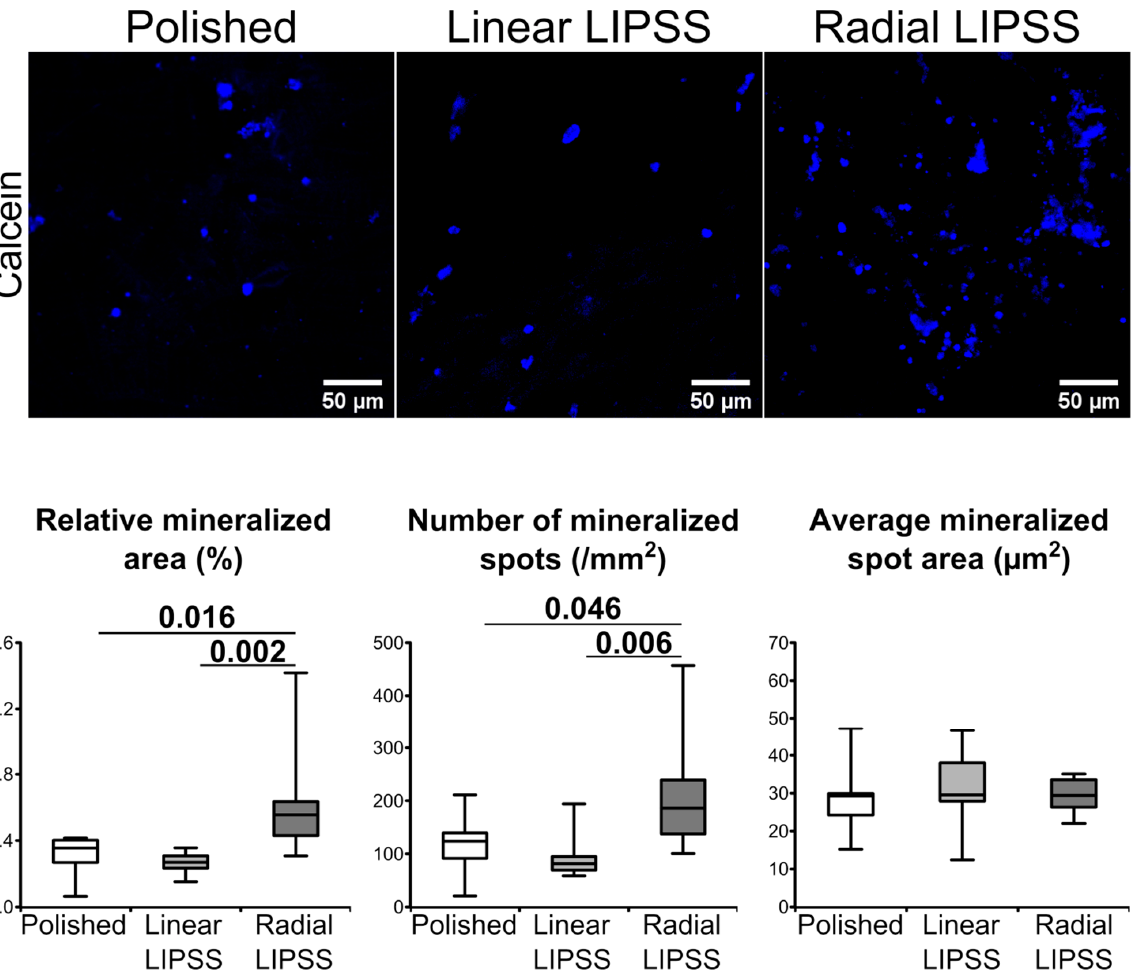
Figure 5. Mineralization clusters labeled by calcein blue (blue) on the polished linear LIPSS and radial LIPSS surfaces at 21 d post seeding. On the bottom of the image are the results of the different quantifications made for the three surfaces. The graphs show the p -values between each group, Mann–Whitney U test, n = 8 fields/group.